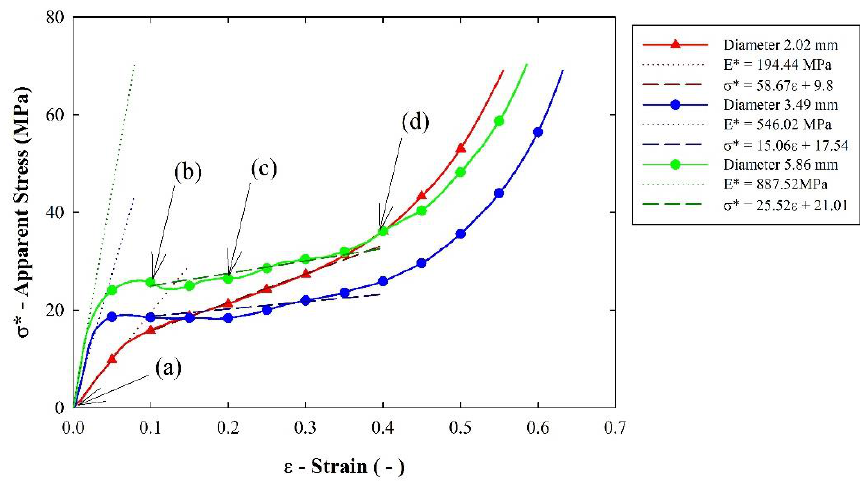
Figure 7. Compressive stress – strain behavior for different particle diameters.